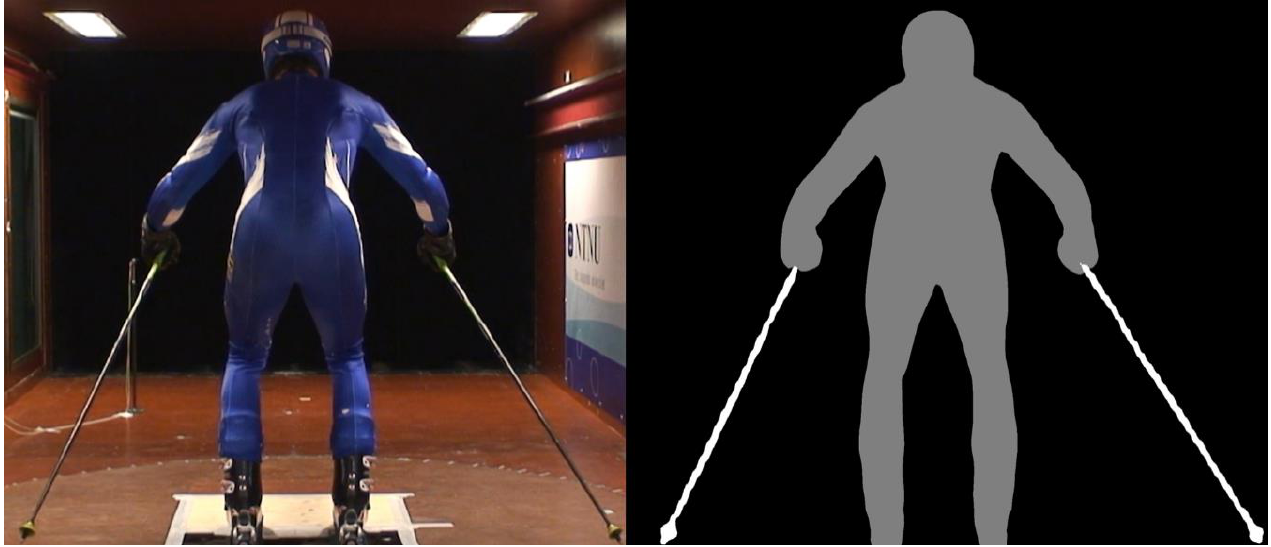
Figure 1. A skier in the wind tunnel filmed from behind ( left ) and the segmentation mask ( right ) used to determine his cross-sectional area.